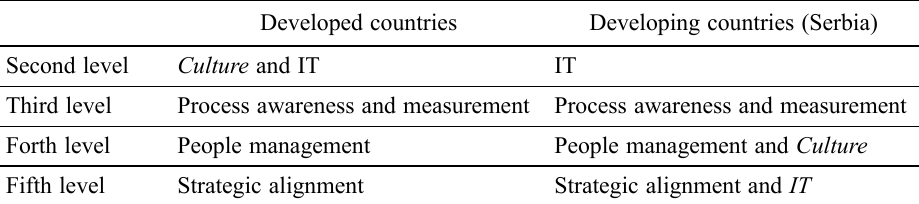
Table 1. Benchmarking of dominant